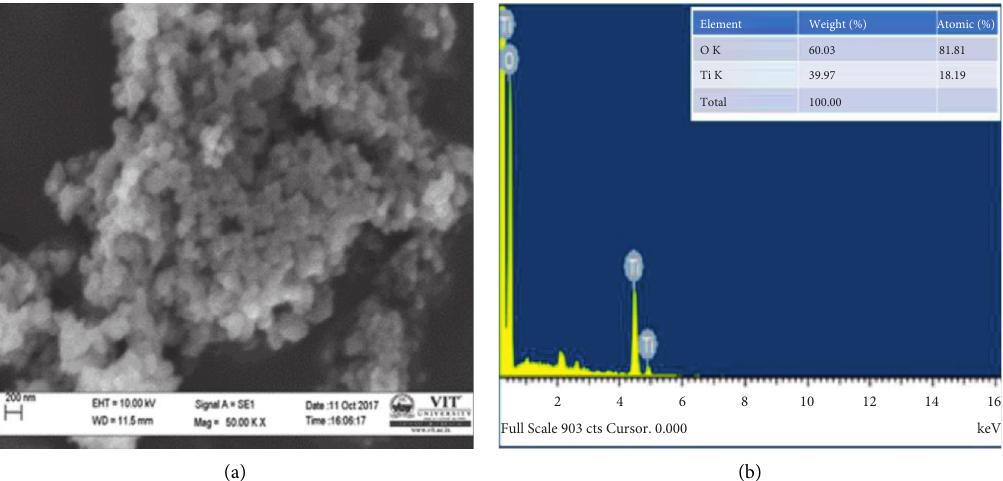
Figure 3: (a) SEM used shape of particle and (b) EDX used element of TiO